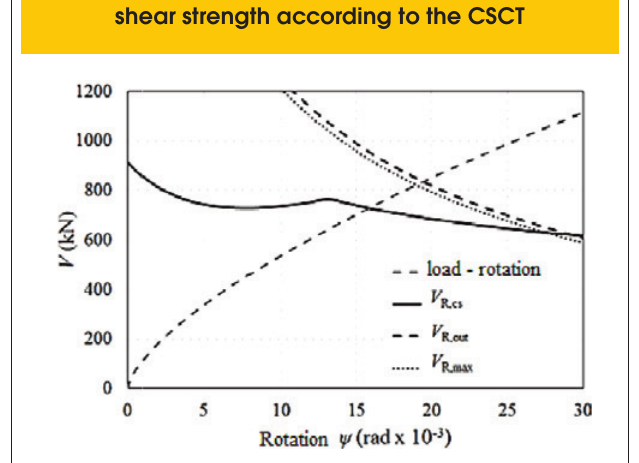
Table 2 - Criteria for evaluating V /V